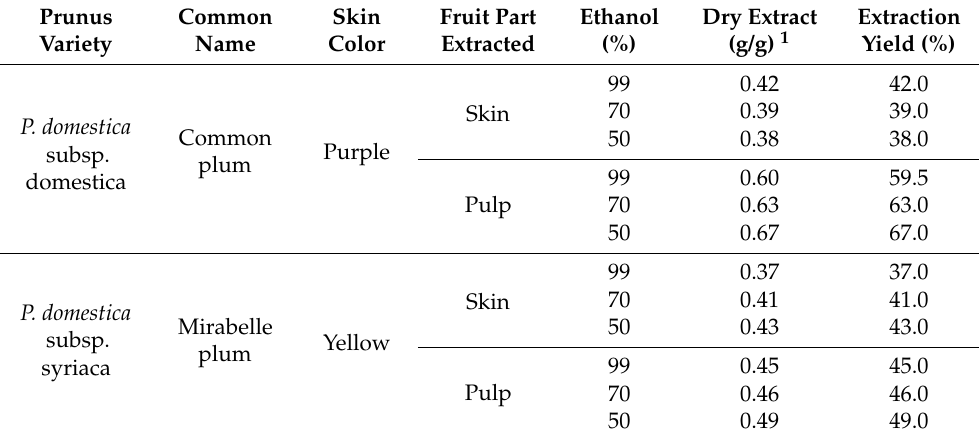
Table 1. Fruit samples and yield of